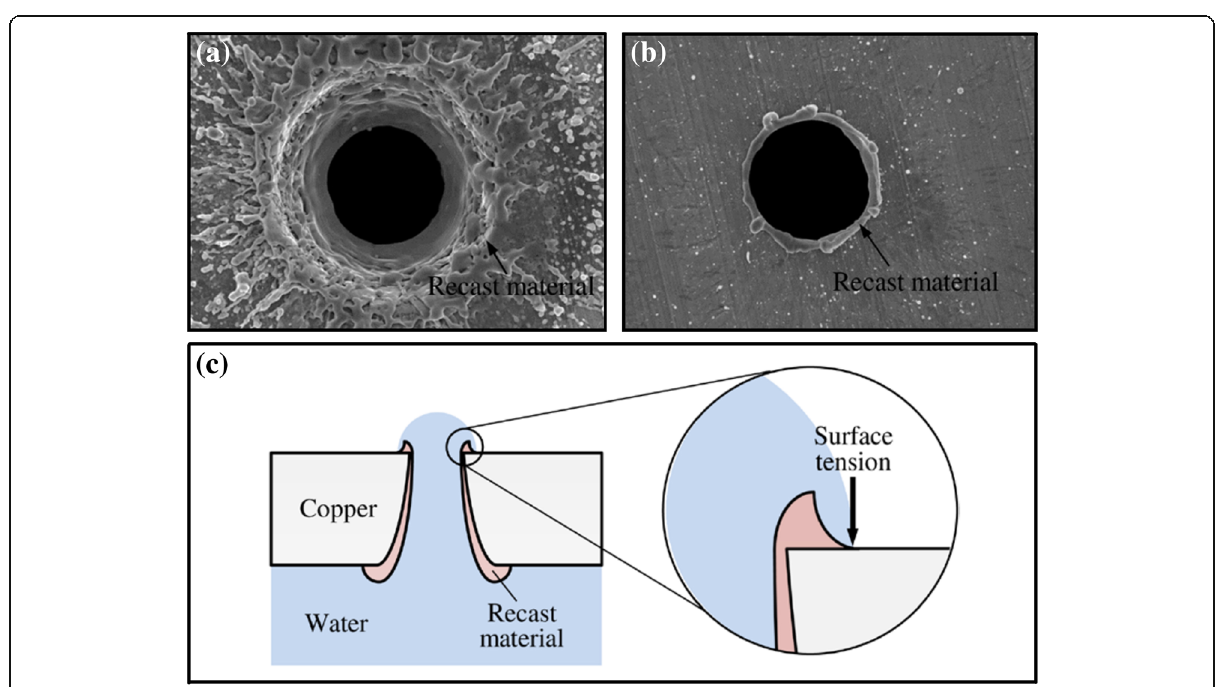
Fig. 9 A hole created using laser beam machining. a The entrance location. b The exit location. (The laser beam conditions are 500 μ J per pulse, 20 kHz and 10 shots) [69]. c The location of the water contact line on a hole with recast material at an equilibrium state [69]